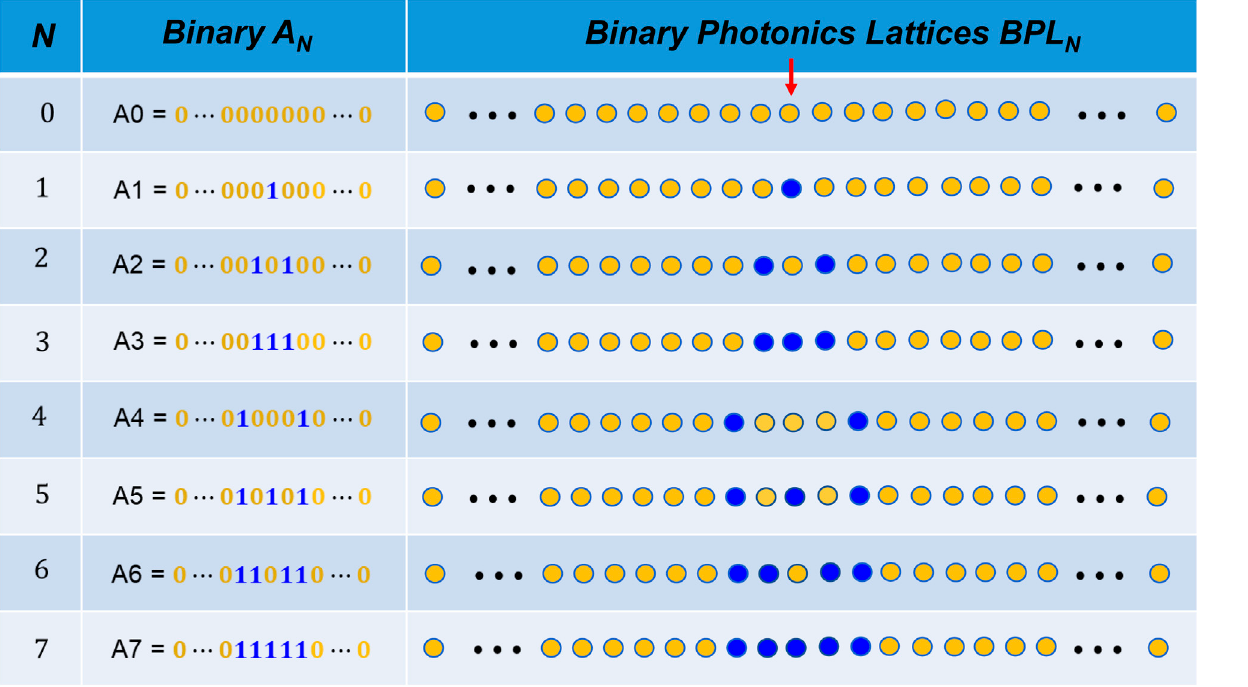
Frontiers in Physics |